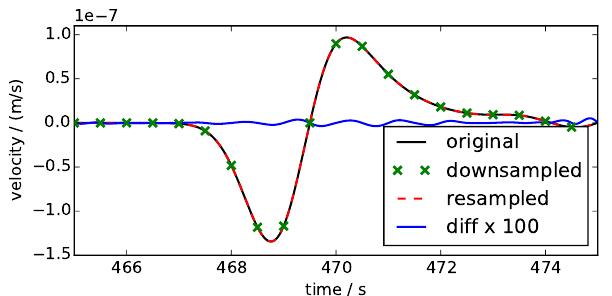
Figure 11. Normalized amplitude spectra of the Gaussian source time function (slip rate) used at 2s mesh period and a vertical com- ponent synthetic seismogram recorded at 40 ◦ epicentral distance. The vertical lines denote the resolution of the mesh and the Nyquist frequency of the downsampling using four samples per mesh pe-